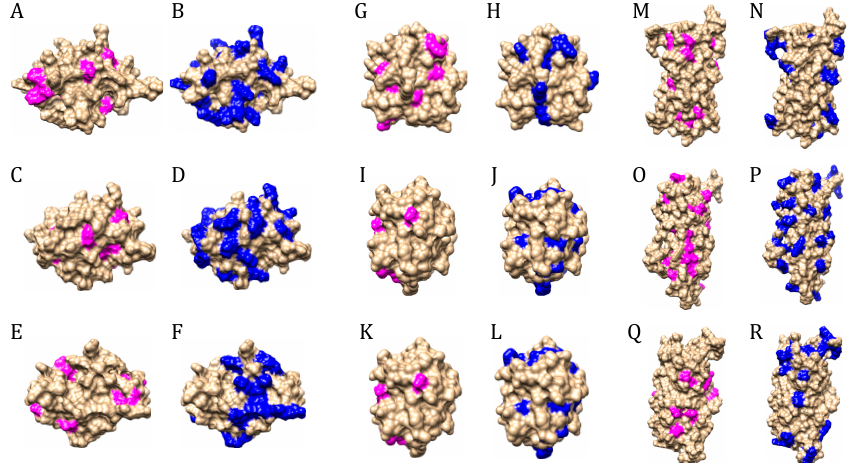
Figure 10. ( A–F ). Distribution of potential cleavage sites for pepsin (magenta) and trypsin (blue) on the molecular surface of chemosensory protein from Apis mellifera ( A,B ), Locusta migratoria ( C,D ) and Tenebrio molitor ( E,F ). ( G–L ). Distribution of potential cleavage sites for pepsin (magenta) and trypsin (blue) on the molecular surface of odorant binding protein from Bombyx mori ( G,H ), Locusta migratoria ( I,J ) and Tenebrio molitor ( K,L ). ( M–R ). Distribution of potential cleavage sites for pepsin (magenta) and trypsin (blue) on the molecular surface of apolipophorin III from Acheta domesticus ( M,N ), Bombyx mori ( O,P ) and Tenebrio molitor ( Q,R ).